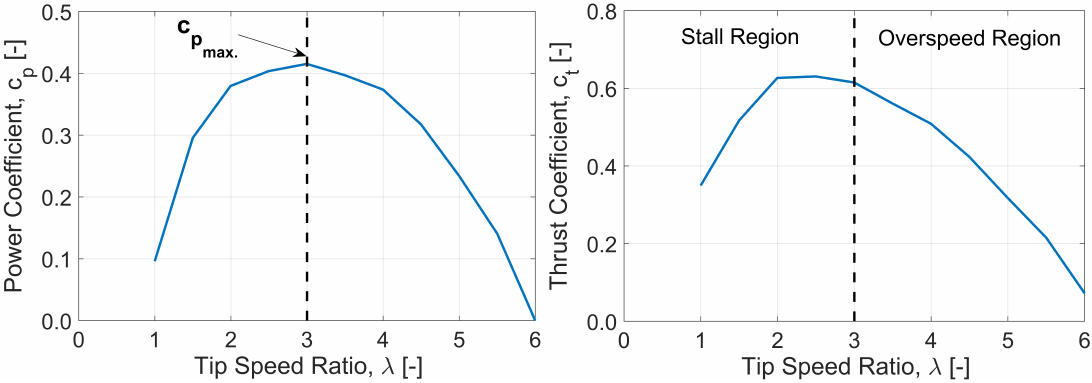
Figure 4. Dimensionless rotor power ( left ) and thrust ( right ) characteristics of the